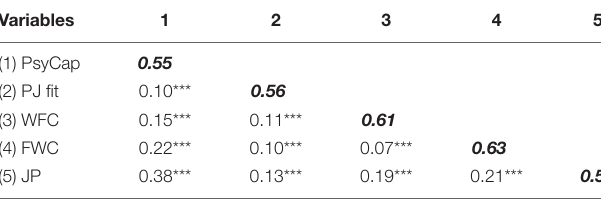
TABLE 3 | Results of the discriminant validity test.